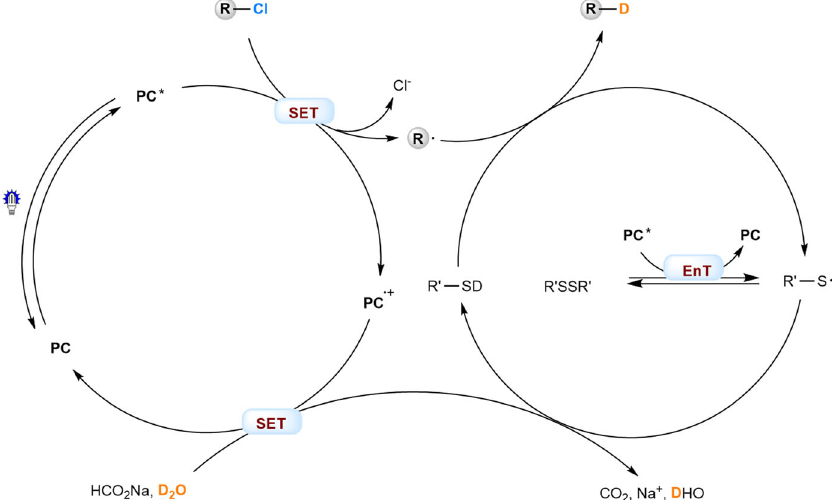
Fig. 8 Proposed reaction mechanism. The photocatalysts are introduced as strongly reducing photoredox catalysts to initiate cleavage of C-Cl bonds, at the same time as energy transfer catalysts to induce homolysis of the disul fi de cocatalysts. PC, photocatalyst; SET, single electron transfer; EnT, energy